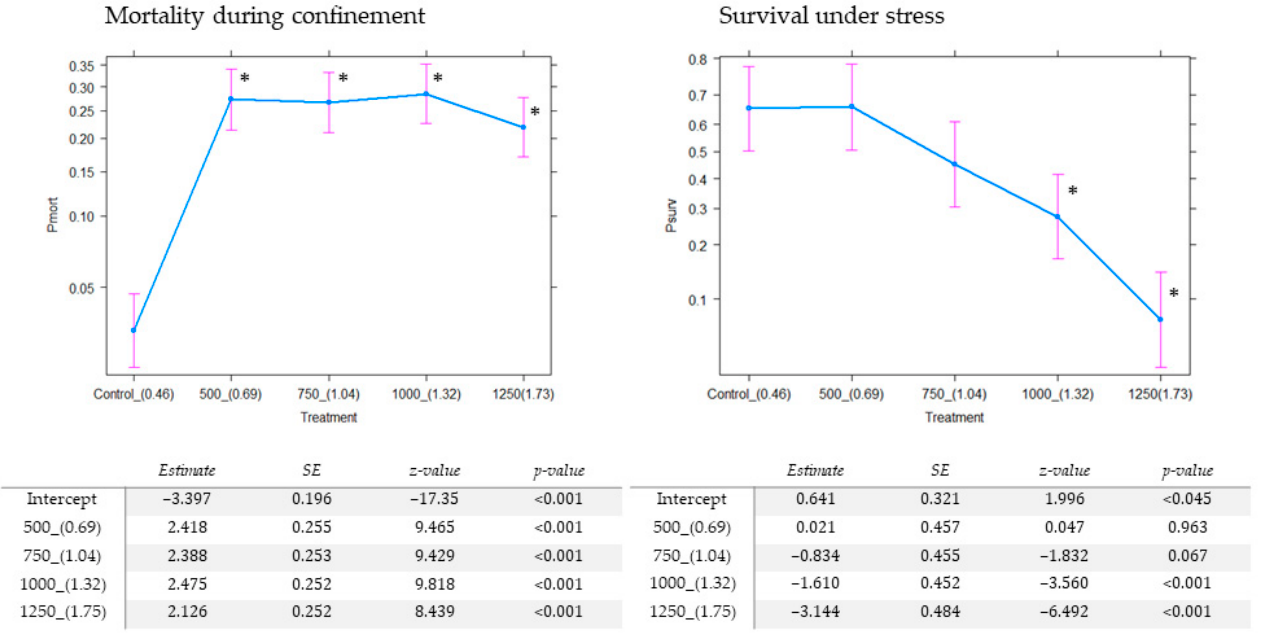
Figure 2. Effect estimates and standard errors derived from the adjusted model of different densities of mosquitoes on two parameters: Probability of death during confinement (Pmort, left ) and probability of survival under stress (Psurv, right ). Four densities of mosquitoes (number of pupae loaded and resting density of vertical surface in mosquito/cm 2 between parentheses) evaluated against the control container. Table: parameter estimation for the effects of different densities of mosquitoes on two parameters with mixed model logistic regression. Asterisks indicate statistical significance compared with the control ( α -level 0.05). Table 1. Parameter estimation to compare mortality during confinement in a new container design and a control. Mortality during